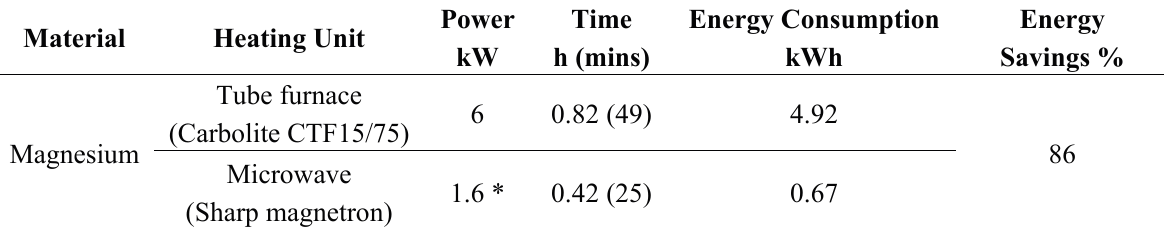
Table 2. Analysis of energy consumption between conventional and microwave sintering during